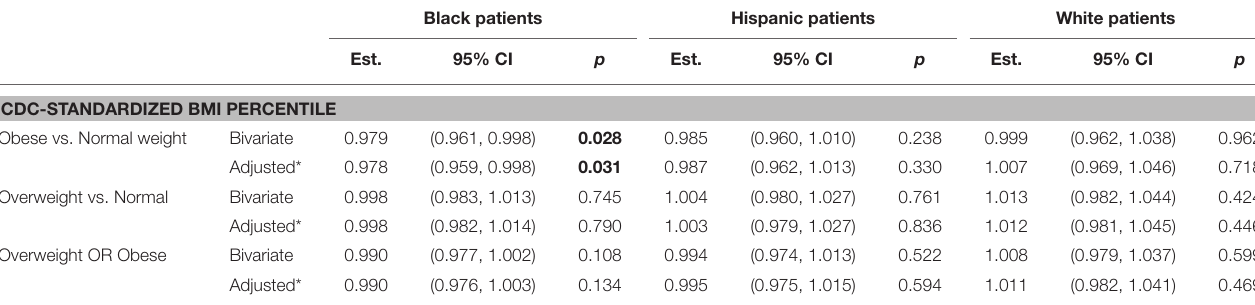
TABLE 2 | Associations between obesity, overweight and overweight or obese and average number of violent crimes in each census block group of patient residence. Black patients Hispanic patients White